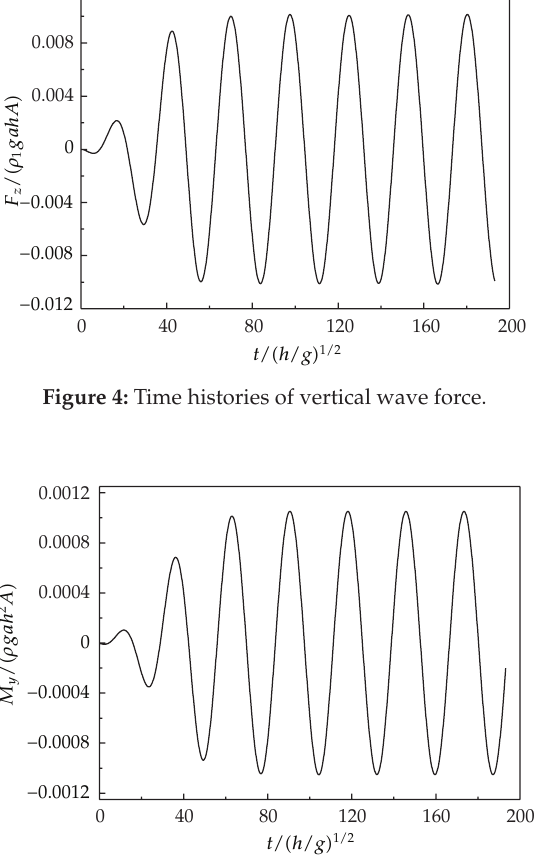
Figure 5: Time histories of pitch